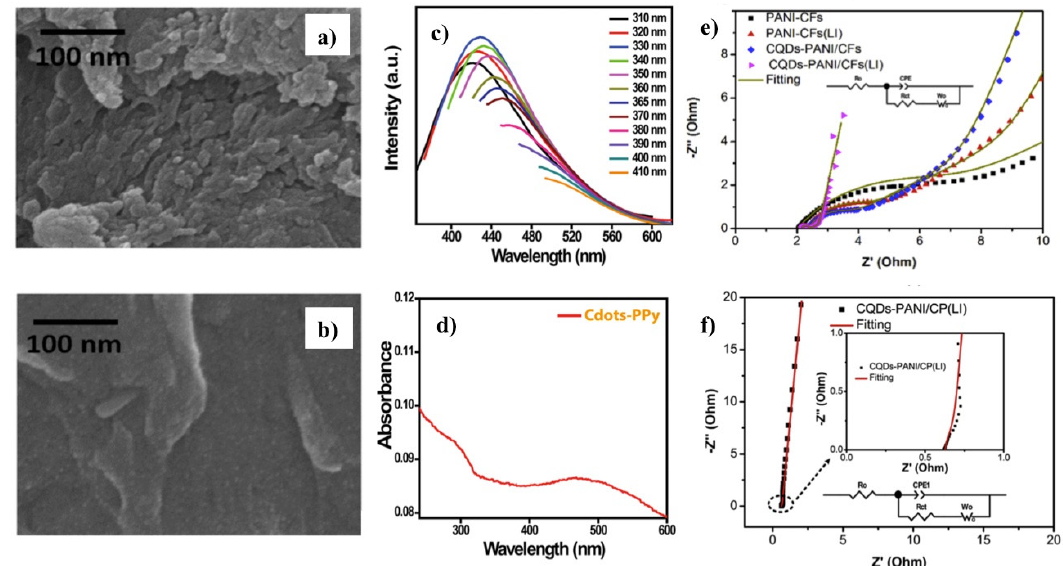
Figure 7. SEM images of ( a ) PPy@Cdots (1:1) and ( b ) PANI@Cdots (1:0.4) supercapacitor. ( c ) Emission spectra of Cdot-PPy composite. ( d ) UV–Vis absorption spectra of CD-PPy composite in water. ( e ) Nyquist plots and the equivalent circuit, ( f ) Nyquist plots of the supercapacitor based on CQDs-PANI/CP(LI) and the corresponding equivalent circuit. Reprinted with permission from reference [37,112,119,128]. Copyright Elsevier (2015, 2017) and American Chemical Society (2016, 2018).